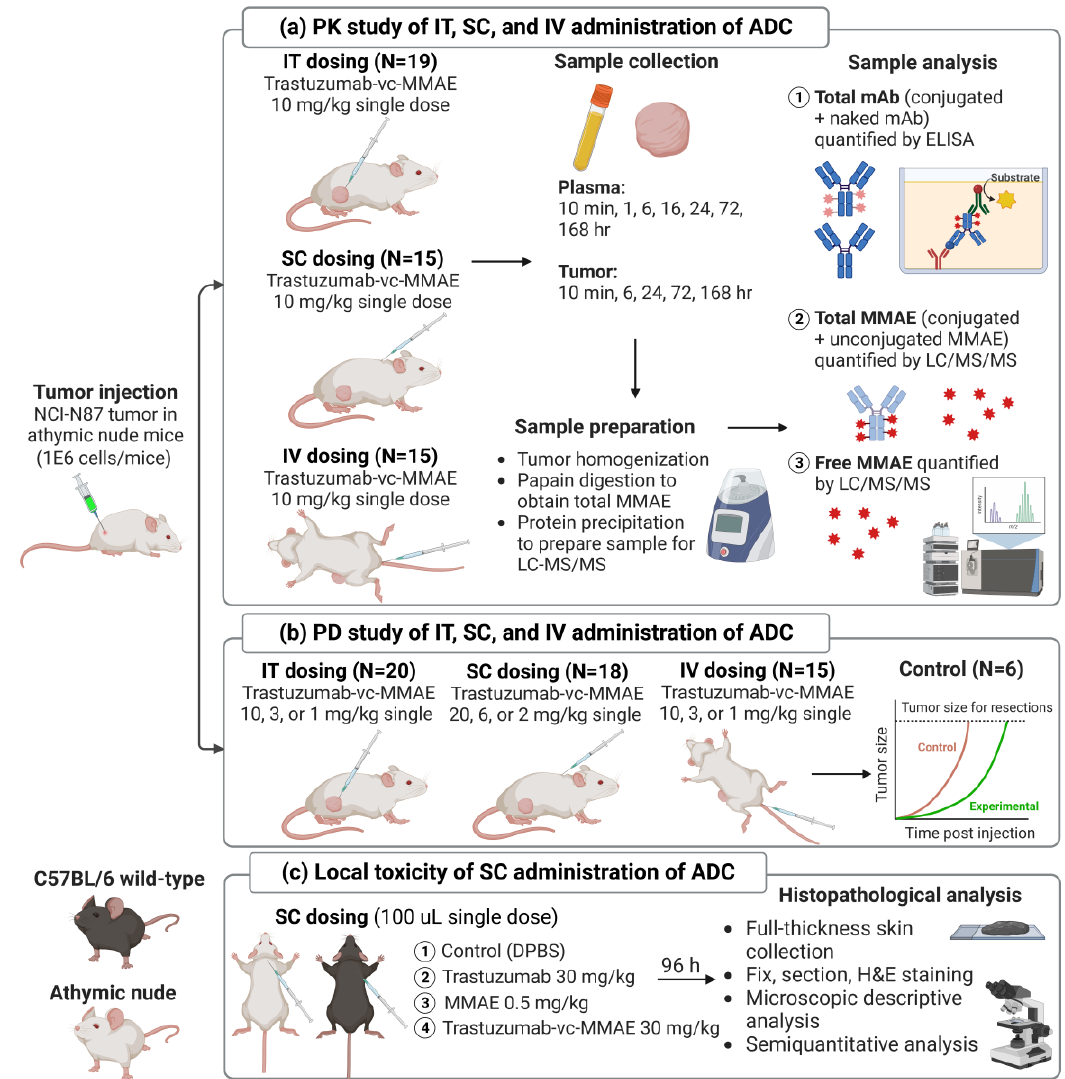
Figure 1. An overview of the experimental design. ( a ) PK study following IT, SC, and IV adminis- tration of 10 mg/kg T-vc-MMAE in NCI-N87 tumor-bearing nude mice; ( b ) efficacy study of IT, SC, and IV administered T-vc-MMAE (high, mid, and low doses) in NCI-N87 tumor-bearing nude mice; ( c ) local toxicity study of SC administered T-vc-MMAE, naked mAb (trastuzumab), naked payload (MMAE), and vehicle control in wild-type and nude mice.